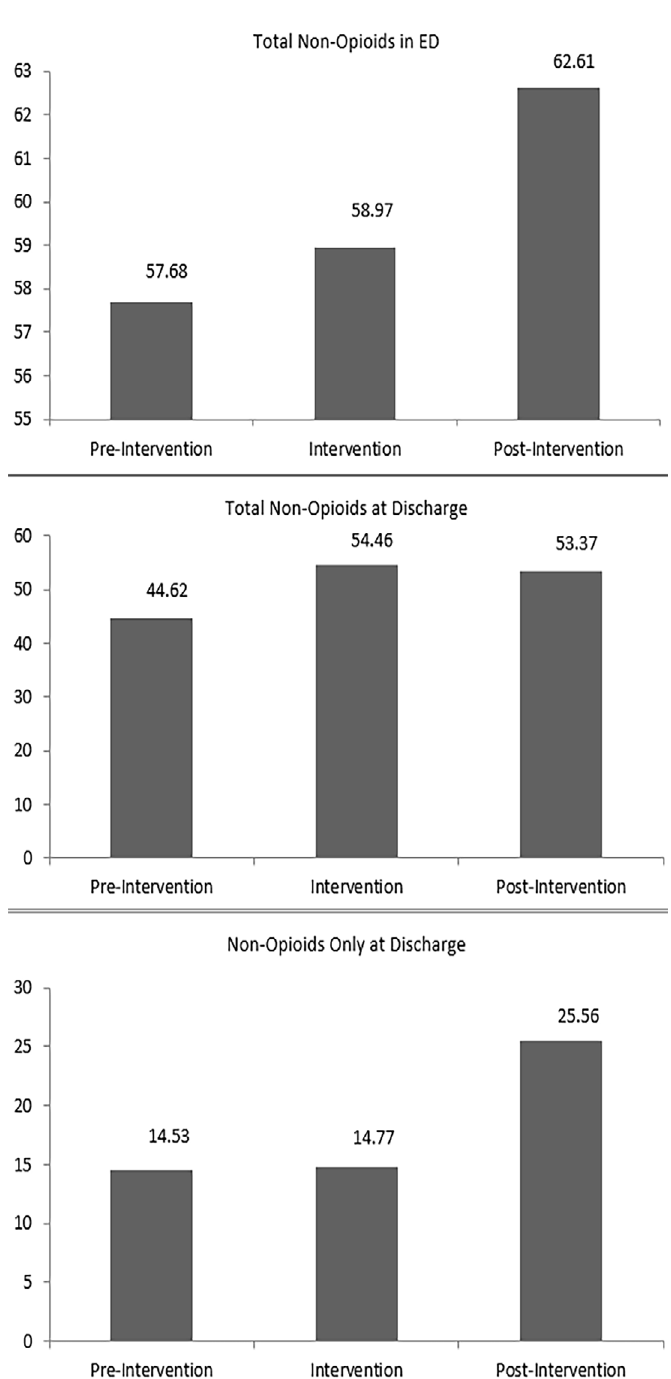
Figure 3. Percentages of non-opioid analgesic administered in the ED and at